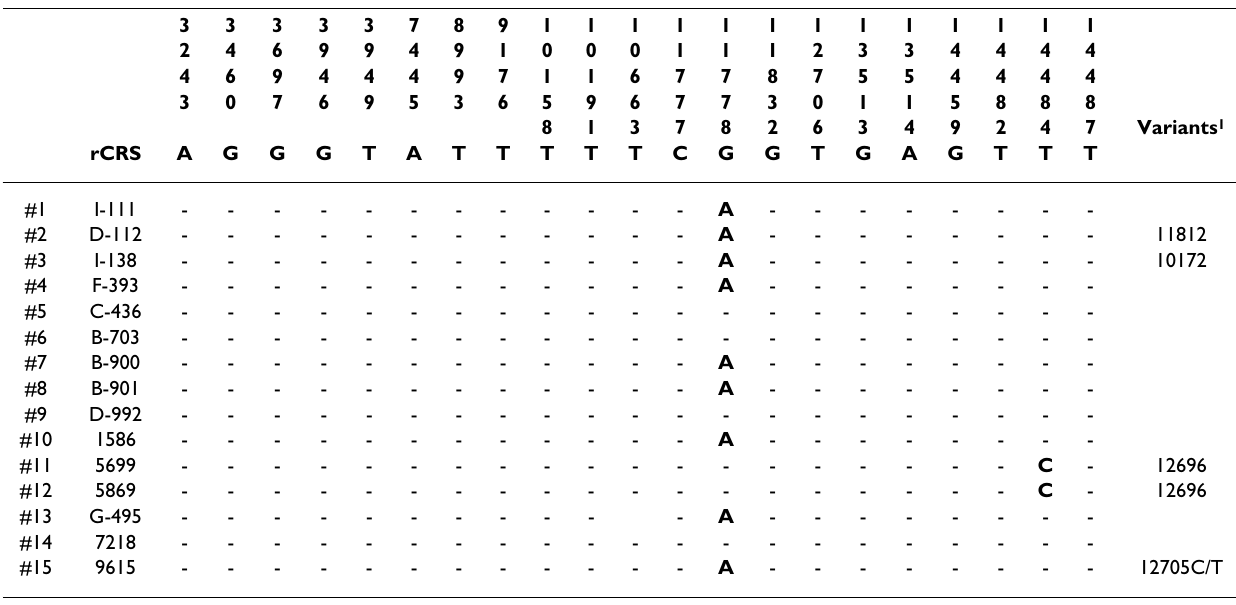
Table 4: Patient samples analyzed in the present study